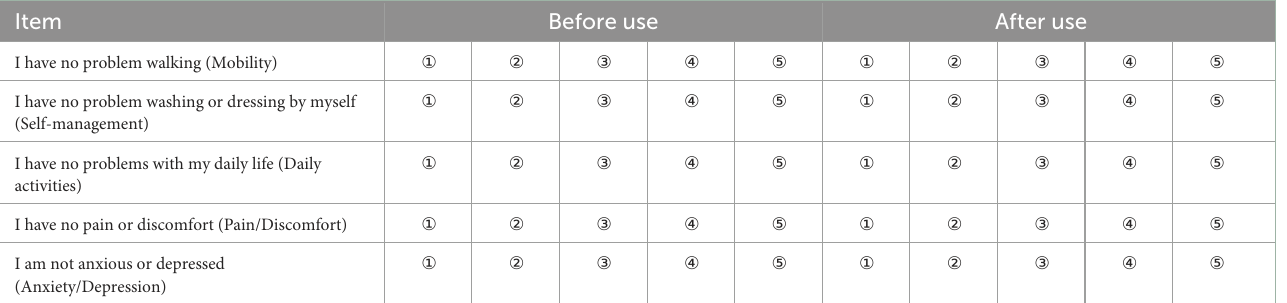
TABLE 1 Questionnaire used to measure subjective quality of life.